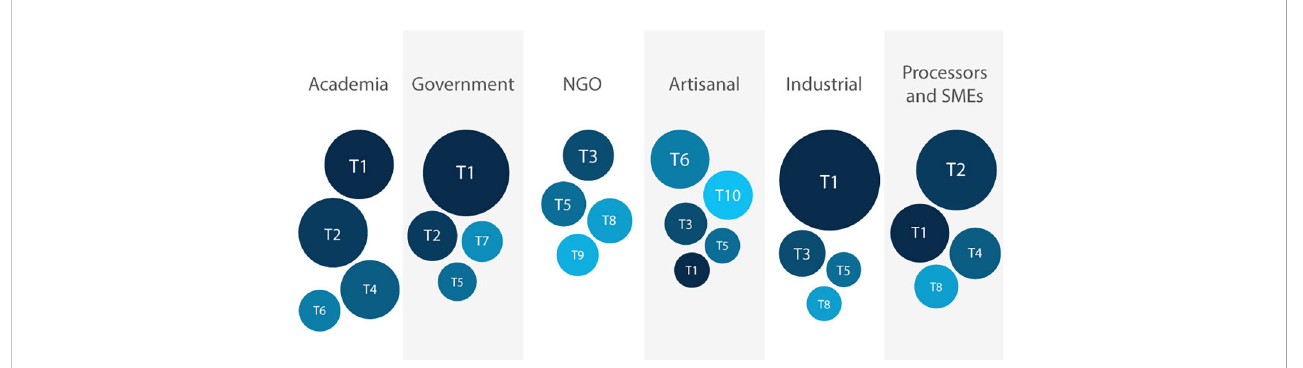
FIGURE 4 The top four improvement priorities in fi sheries policies identi fi ed per respondent ’ s sector. The artisanal sector has fi ve improvement priorities because the last two priorities were tied in terms of scoring points. The topics are provided in Table